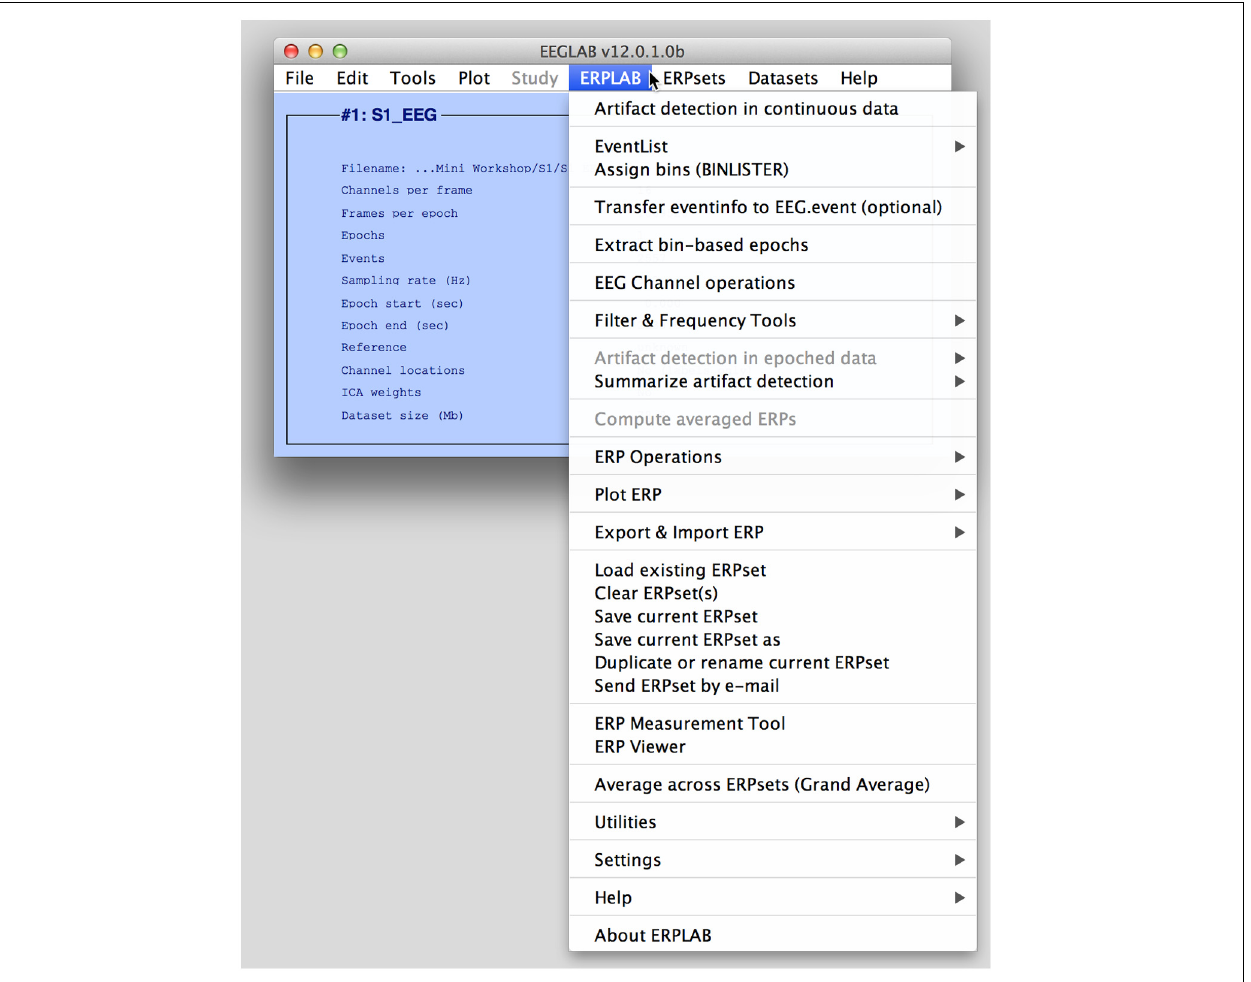
FIGURE 1 |The main EEGLAB graphical user interface, with the ERPLAB menu activated. The Datasets menu shows a list of currently active EEG sets, and the ERPsets menu shows a list of currently active ERP sets.